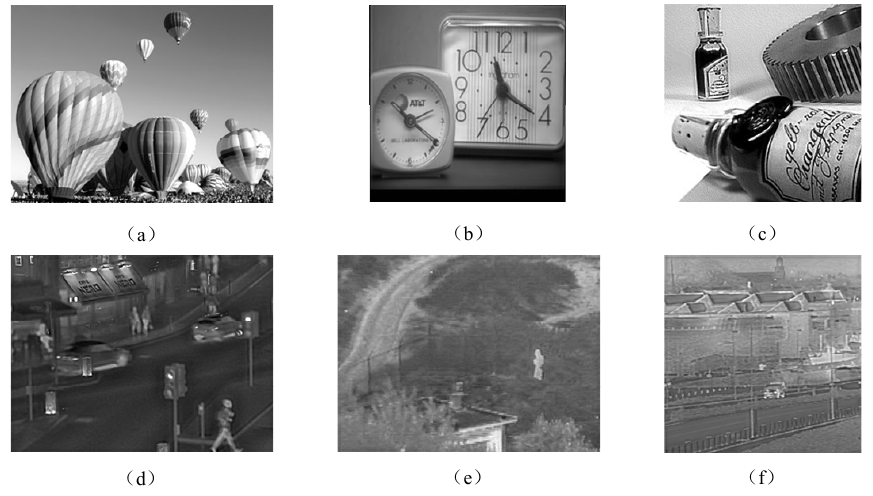
Figure 9. Image Fusion Results of Proposed Solution in Different Scenes, ( a )–( c ) are the fused multi-focus images; and ( d )–( f ) are the fused infrared-visible